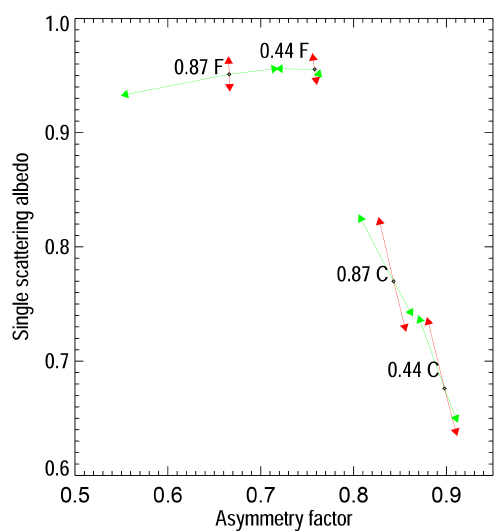
Figure 2. Example of sensitivity of aerosol single-scattering prop- erties to particle median radius (green arrows) and imaginary part of the refractive index (red arrows) at 0.44 and 0.87µm for fine-mode, F ( r mf = 0 . 1µm), and coarse mode, C ( r mc = 2 . 0µm). The length of the arrows reflects the magnitude of the